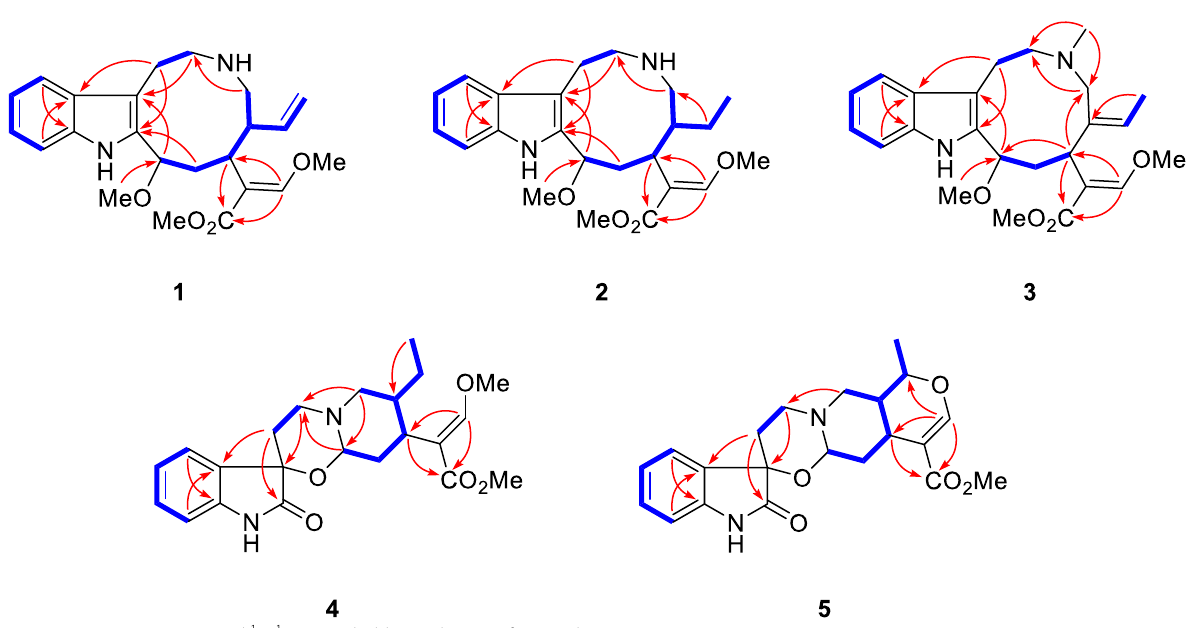
Fig. 2 Key HMBC (arrow) and 1 H‑ 1 H COSY (bold) correlations of uncarialines A‑E ( 1 – 5 )